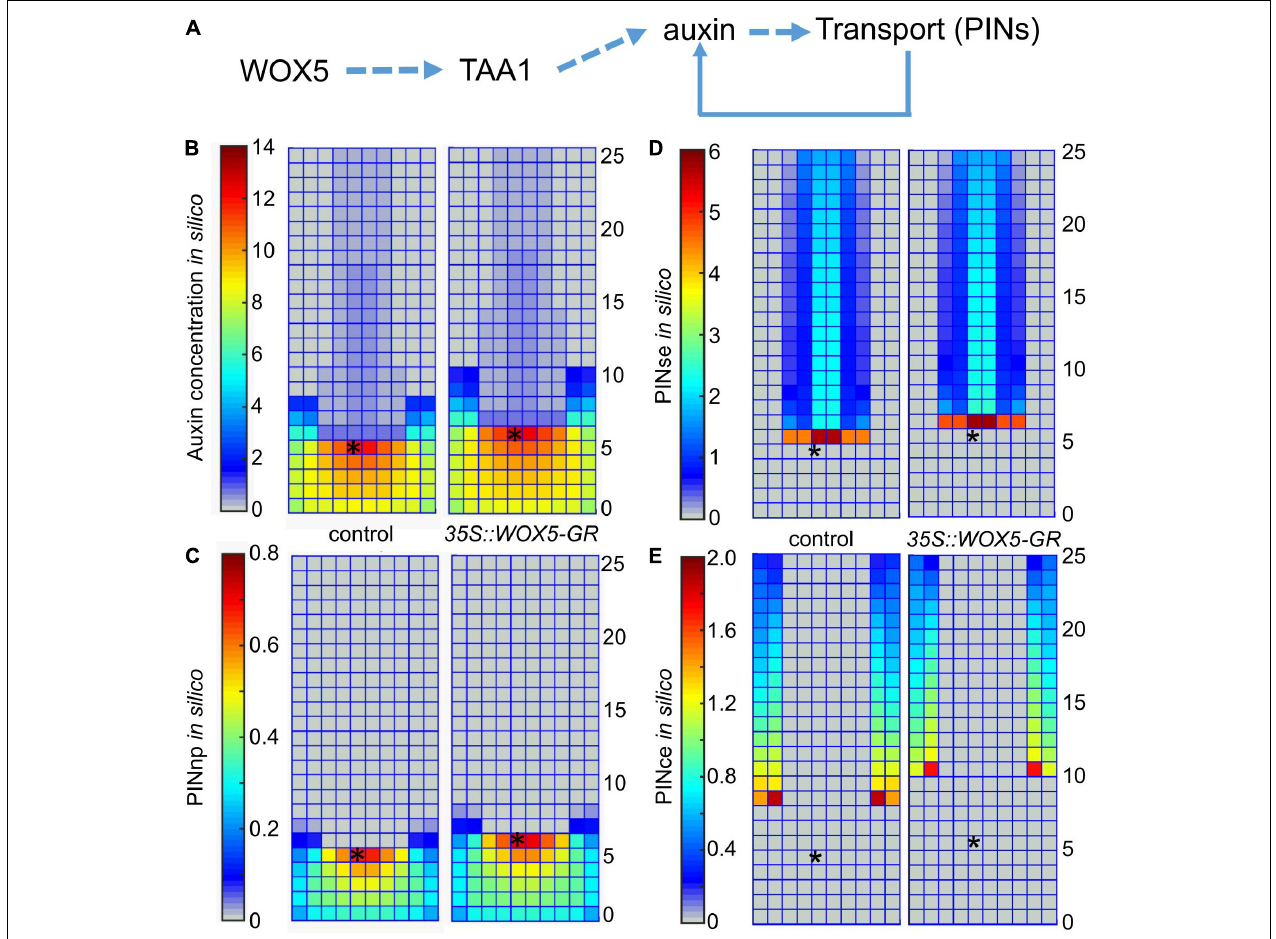
FIGURE 5 | Simulation of auxin patterning in the root tip of control and 35S:WOX5-GR plants after DEX exposure. (A) The hypothesis of WOX5 effect on auxin redistribution considered in the 2-dimensional mathematical model. (B–E) The steady state solutions for the 2D cell layout that simulates the longitudinal cut of the root tip in control and the 35S:WOX5-GR plants after DEX exposure; (B) auxin distribution, (C) non-polarly localized auxin transporters in the root cap (PINnp), (D) rootward polarized auxin transporters in the stele and endodermis (PINse), (E) PINce transporter polarized rootward in the cortex and shootward in the epidermis. The QC location is marked by the black